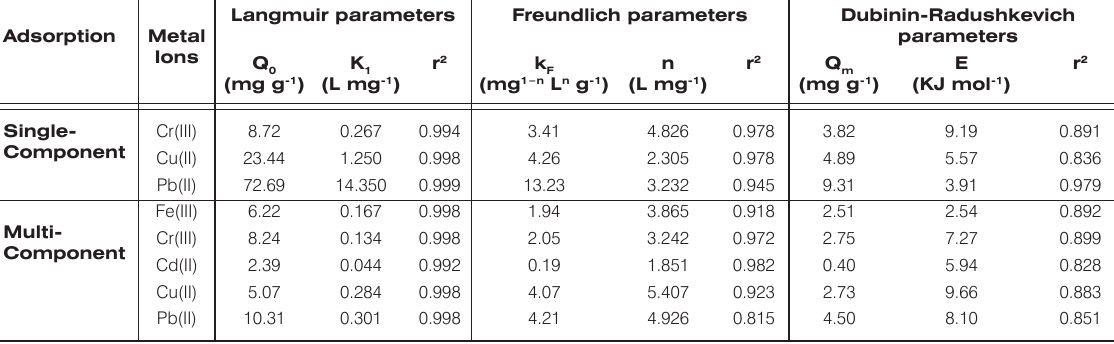
Table 2. Isotherm constants for single- and multi-component adsorption of metal ions onto Si-10Al